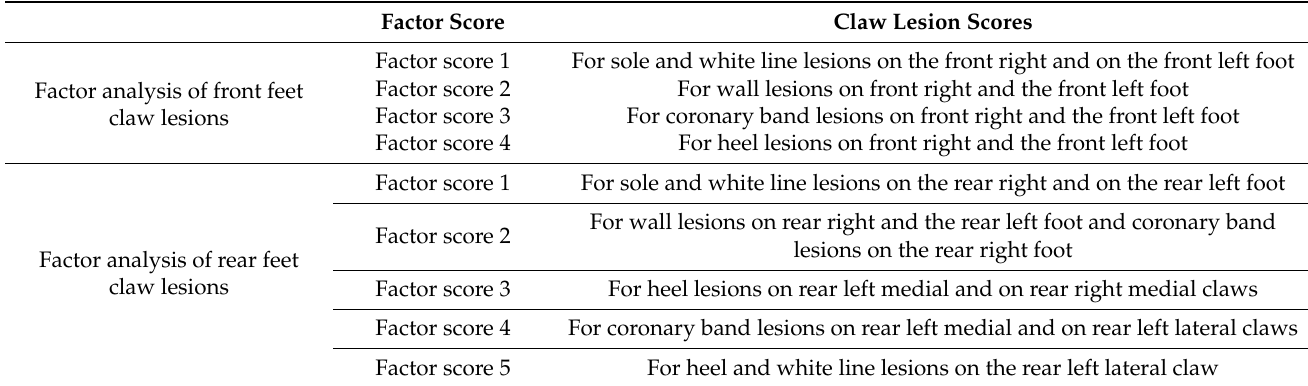
Table 6. Factor scores, with loadings > |0.4,|, produced from factor analyses of claw lesion scores of front and rear feet main toes of 185 culled sows from three Greek herds, examined for association with the score for the sum of length measurements of the main toes of the front feet and the score for the sum of length measurements of the main toes of the rear feet.